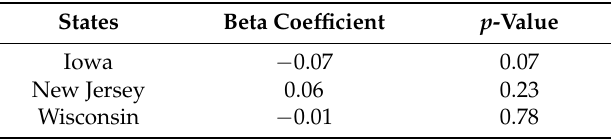
Figure 3. ( a ) Map of Quartiles of Radon Concentrations in Wisconsin counties. Darker shades represent a higher percent of radon above 4pCi/L. The numbers inside the brackets represent the range of percentages in that shade. The numbers inside the parentheses represent the number of counties in that quantile. Data accessed from AirChek, 2017. ( b ) Map of Quartiles of Age-adjusted Thyroid Cancer Incidence (1990–2013) in Wisconsin counties. Darker shades of orange represent higher rates of thyroid cancer incidence. The blue color represents the counties that lacked data from the public database. The numbers inside the brackets represent the range of incidence rates per 100,000 in that shade. The numbers inside the parentheses represent the number of counties in that quantile. Table 2. Beta coefficients from ordinary least-squares regression of percent of radon above 4 pCi/L on age-adjusted thyroid cancer incidence rate in county-level data from 3 US States. Cancer incidence 1990–2013.